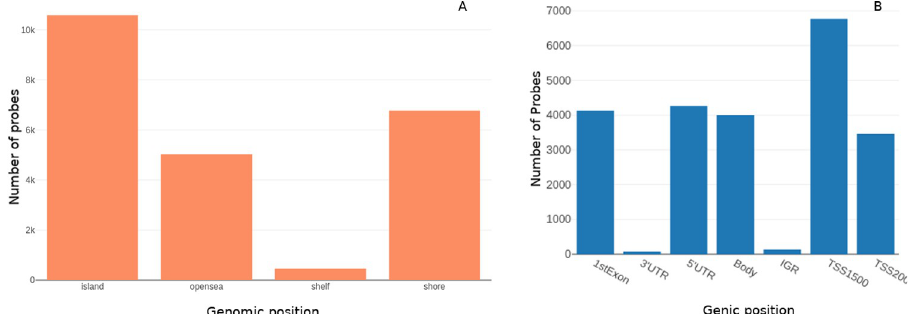
Fig 4. Distribution of probes based on (A) genomic position: opensea, shore, island, shelf; (B) gene context: transcription start site (TSS), exons, untranscribed regions (UTRs), and intergenic regions (IGR).